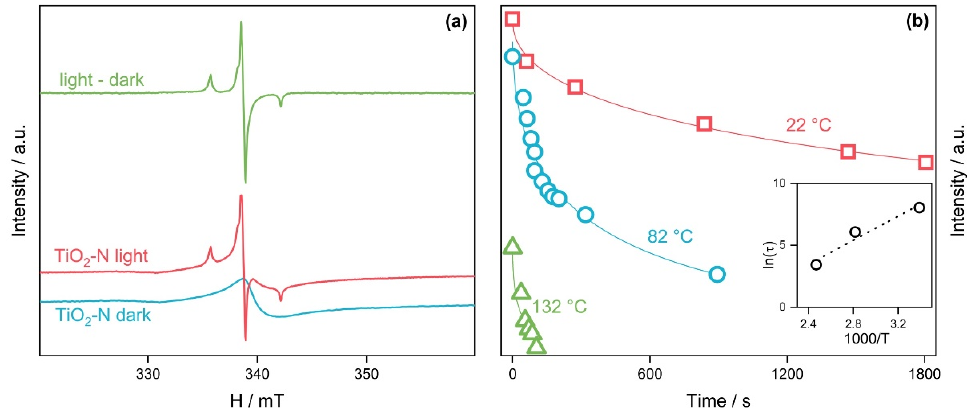
Figure 5. EPR spectra of TiO 2 -N in the dark or under light exposure ( a ) and decay plots for the intensity of the EPR signal at different temperatures ( b ). The inset in ( b ) shows the temperature dependence of the average decay time. Table 2. Parameters of individual components in EPR